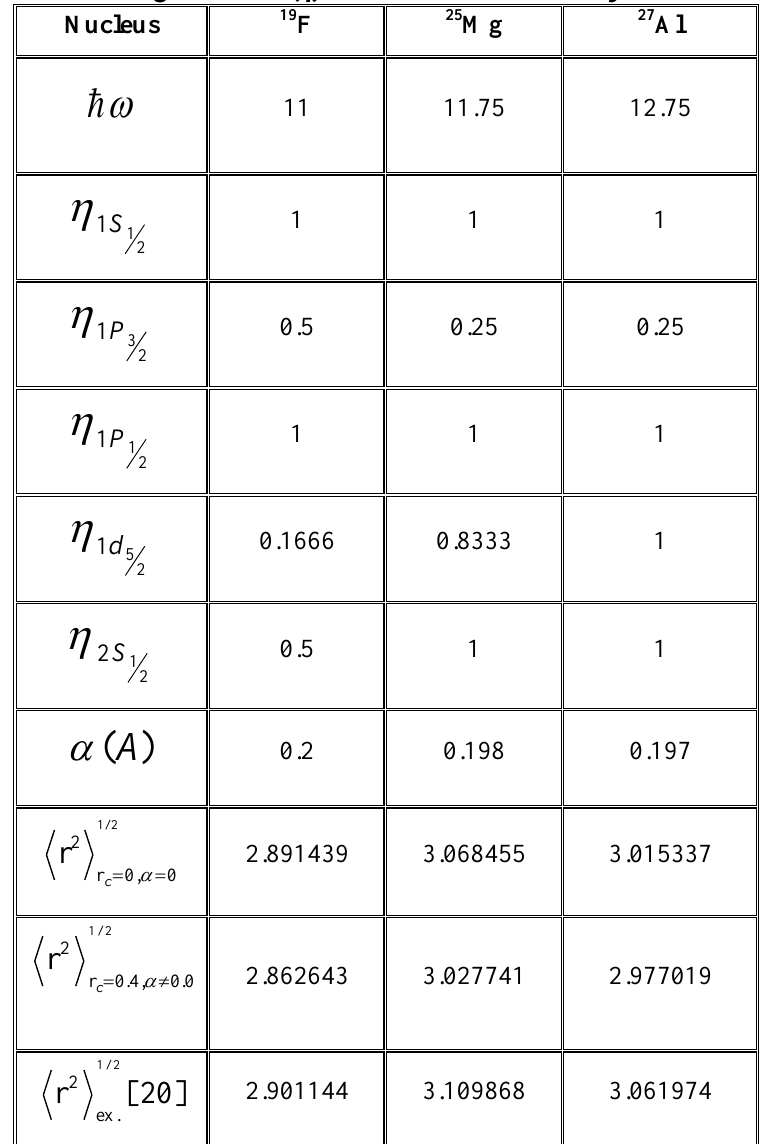
Table 1: Parameters which have been used in the calculations of the present work for the 2BCDD's, and elastic longitudinal F (q)'s of all nuclei under